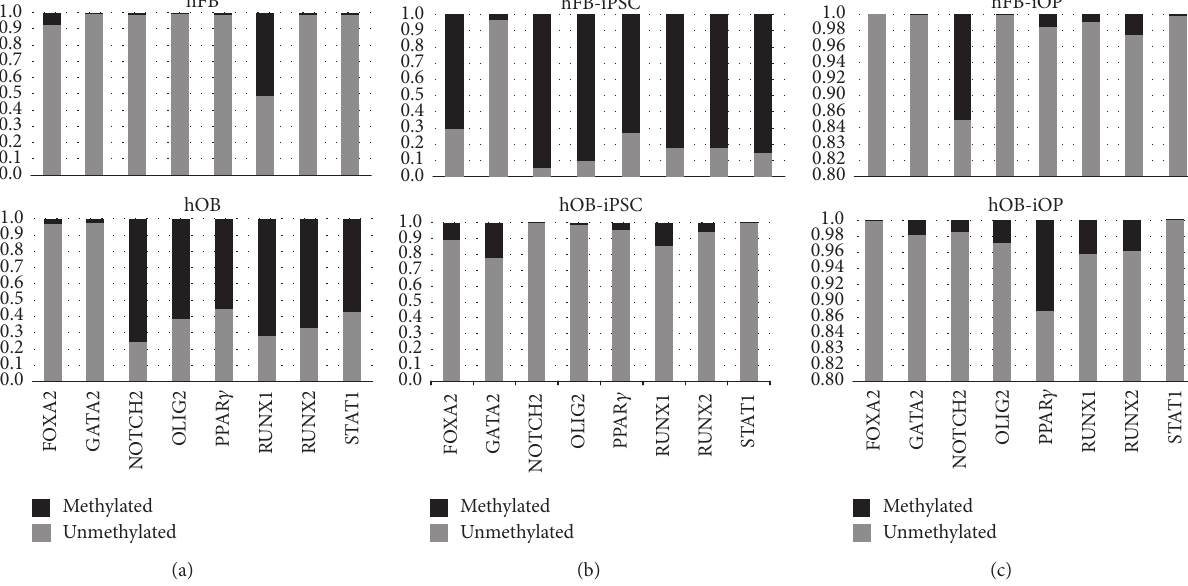
Figure 6: Promoter methylation analysis for unreprogrammed, parental iPSC, and iOP cells. Methylation sensitive enzymatic digestions were performed for hFB and hOB (a), hFB-iPSC and hOB-iPSC (b), and hFB-iOP and hOB-iOP (c). Graphs indicate promoter percent methylated (black) versus percent unmethylated (gray) of a subset of genes: endoderm (FOXA2, STAT1), ectoderm (OLIG2), and mesoderm (NOTCH2, GATA2, PPAR 𝛾 , RUNX1, and